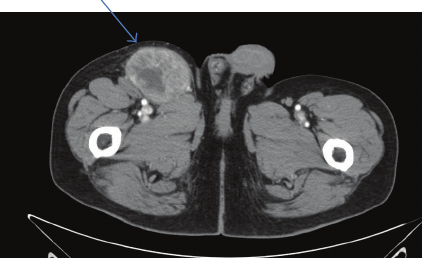
Figure 1: Technique . Axial images were obtained from the lower chest to the pubic symphysis with intravenous and oral contrast. Patient received 125 milliliters of Omnipaque 350 as a contrast agent. Findings . Lymph nodes: a necrotic appearing, enlarged right inguinal lymph node is noted, measuring 5.0 × 7.1cm (blue arrow). Multiple other right inguinal lymph nodes are noted, borderline in size. An enlarged right external iliac lymph node is seen on measuring 2.0 × 1.5cm. A mildly enlarged 1.5 × 1.1cm right external iliac lymph node is seen just posterior to this. Nothing abnormal is detected in abdomen or pelvis worthy to